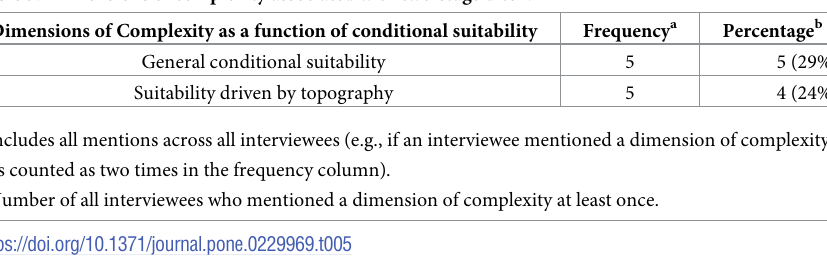
Table 5. Dimensions of complexity associated with two-stage